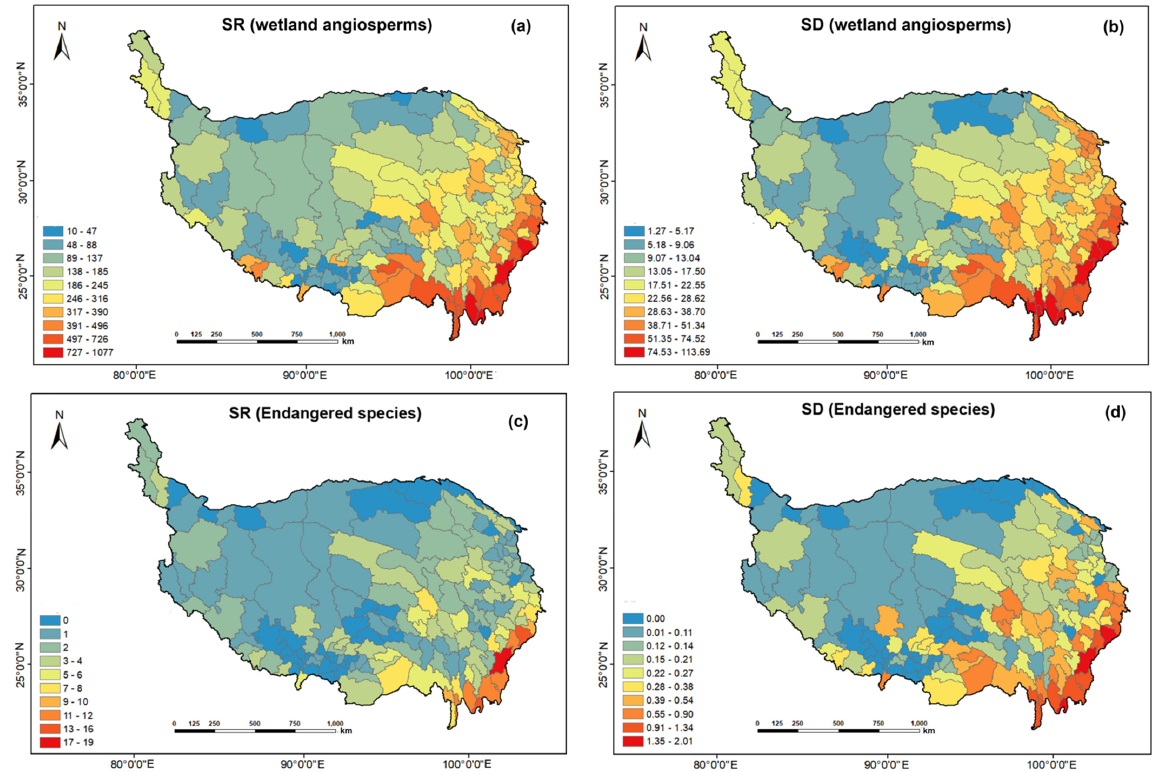
Figure 3. Distribution pattern of species richness (SR) and species density (SD) of wetland angiosperms (including endangered species) in the Qinghai-Tibet Plateau, projected in ArcGIS 10.2. ( a , b ) wetland angiosperms Species Richness (SR) and Species Density (SD); ( c , d ) Endangered wetland angiosperms Species Richness (SR) and Species Density (SD).